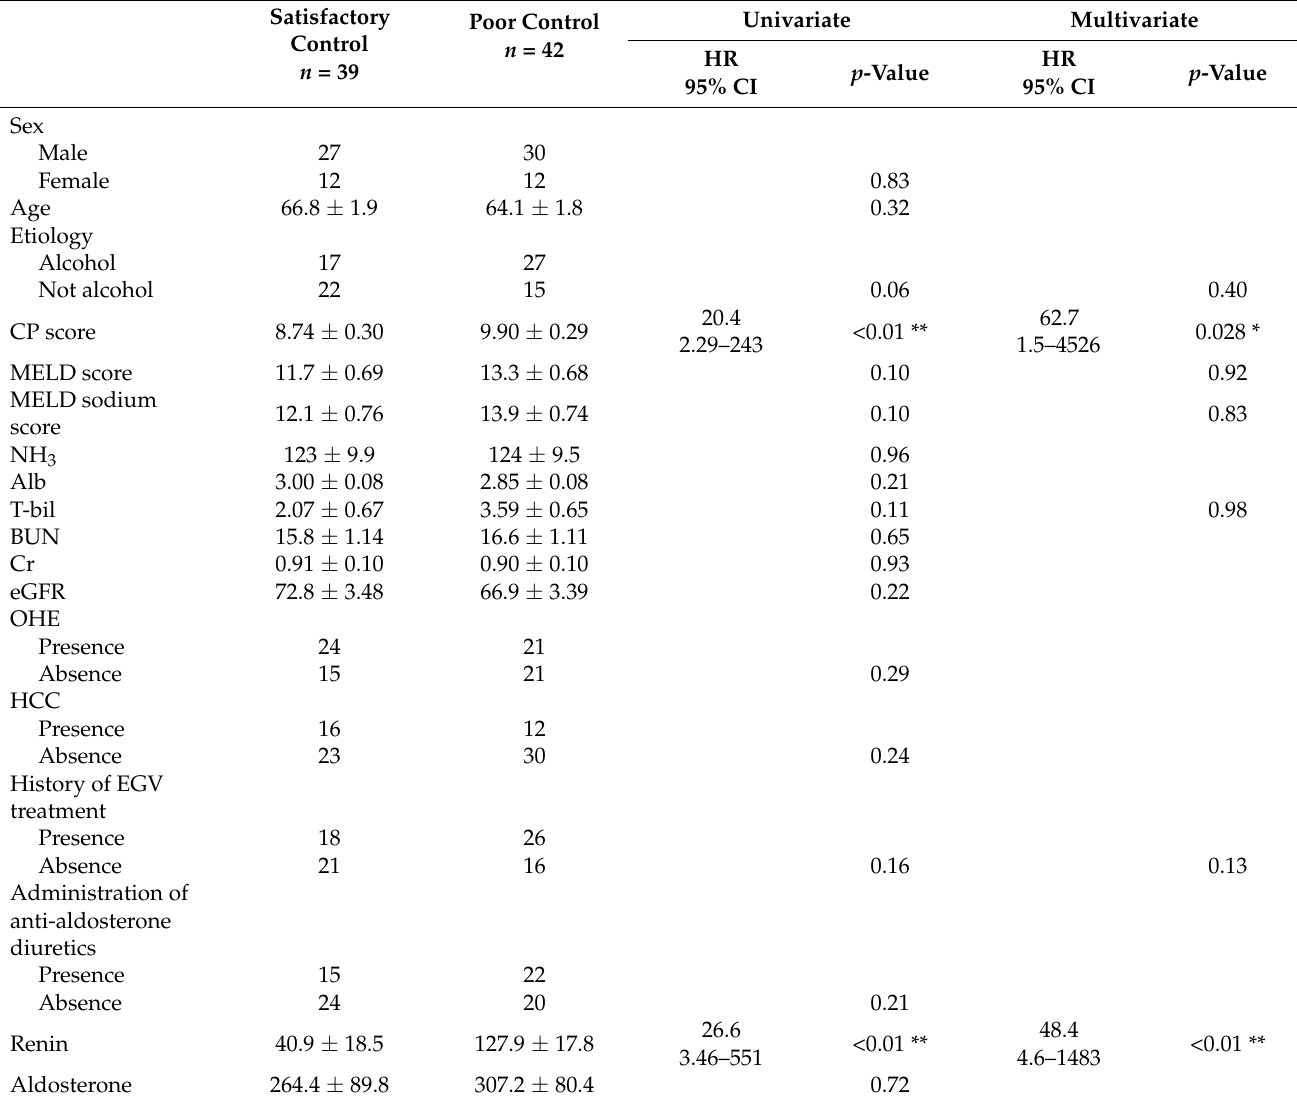
Table 3. Univariate and multivariate analyses of factors involved in satisfactory hepatic ascites control 3 months after RFX administration ( n =